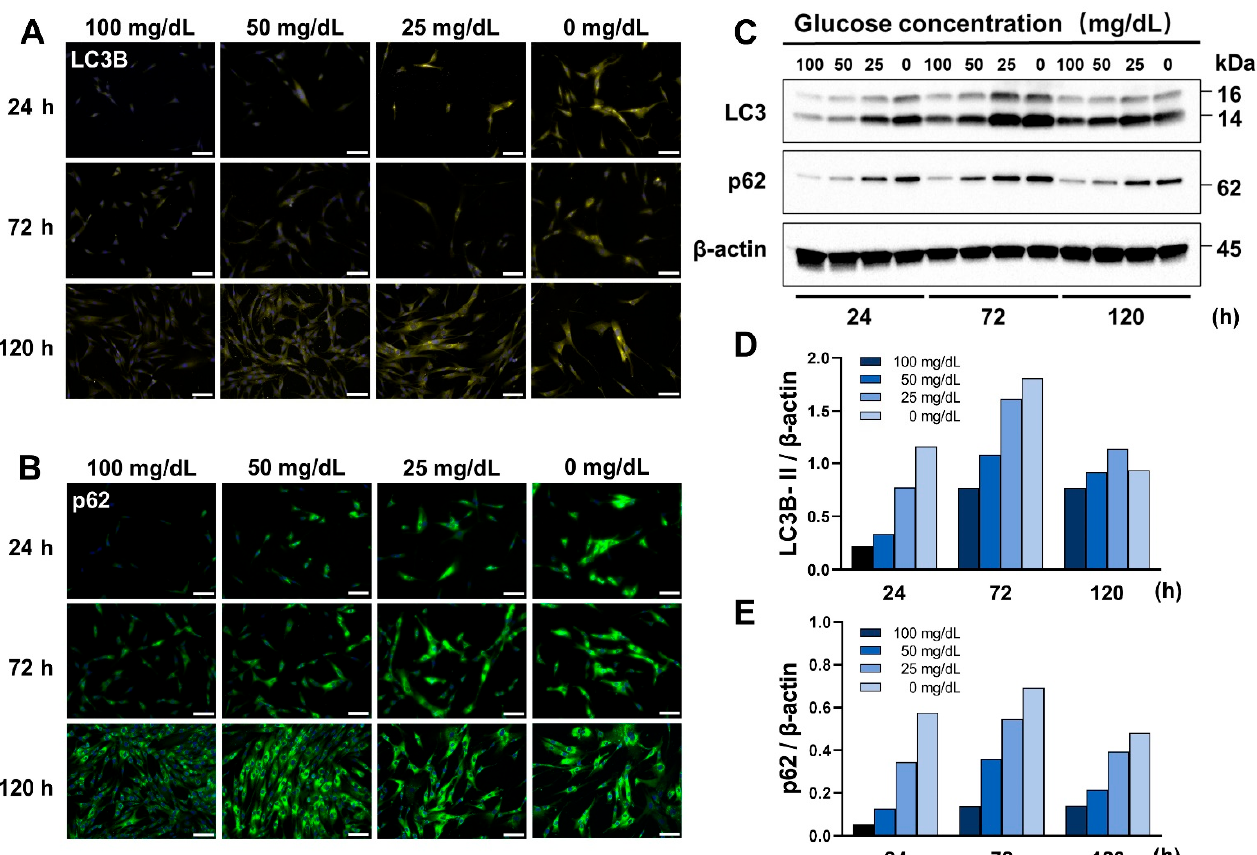
Figure 3. Low glucose conditions induce autophagy in HGnFs. ( A , B ) Synthesis of autophagy-related proteins (Total-LC3B and p62) by HGnFs under low glucose conditions, after 24, 72, and 120 h of incubation. The HGnFs were photographed after incubation with fluorescently labeled secondary antibodies, and nuclei were stained with DAPI. ( C – E ) The expression of LC3B and p62 was examined using western blot analysis; the data were obtained using protein extracts of these cells with antibodies against the indicated proteins with β -actin as a loading control. The samples derived from the same experiment and their corresponding gels/blots were processed in parallel. (Scale bars: 100 μ m).